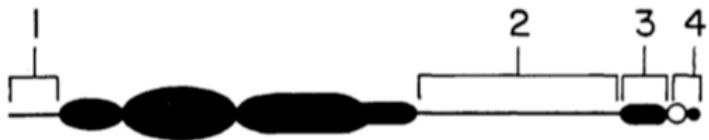
Figure 3. Structure of the maize B chromosome, based on Carlson [26]. See text for details of the numbering of the segments.